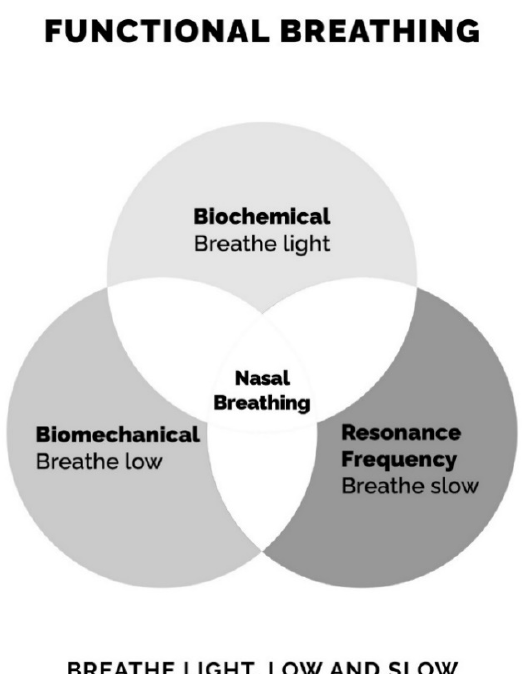
Figure 1. Breathing re-education is based on three dimensions. The causes of dysfunctional breathing are biomechanical, biochemical and psychological. Breathing re-education (BRE) approaches these from three dimensions, each underpinned by full-time nasal breathing. (1) Biomechanical, breathe low to engage the diaphragm. (2) Biochemical, breathe light, reduce tidal volume and lessen chemosensitivity to CO 2 . (3) Resonant frequency—slow breathing at six breaths per minute.